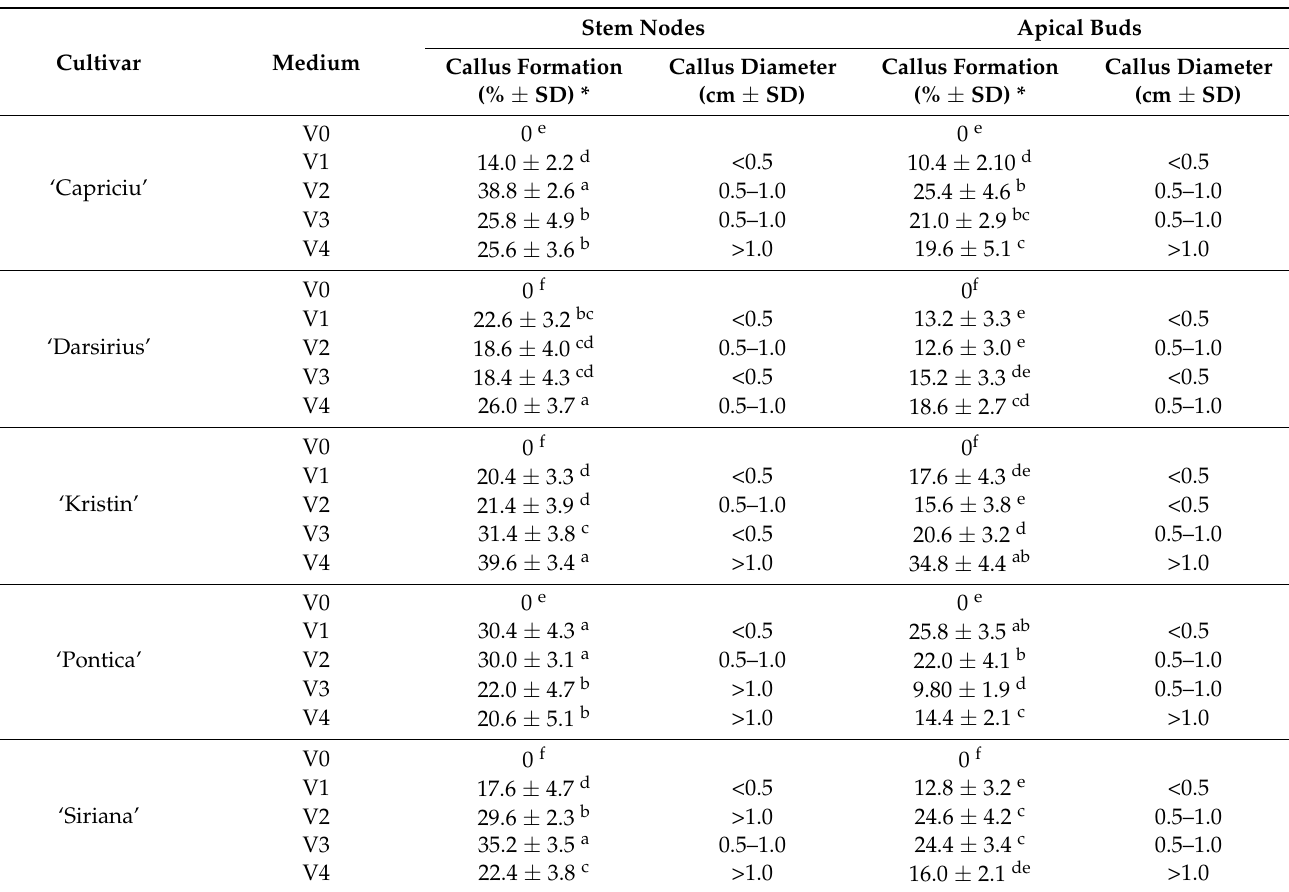
Table 6. Callus formation from stem nodes and apical buds grown on culture media with different